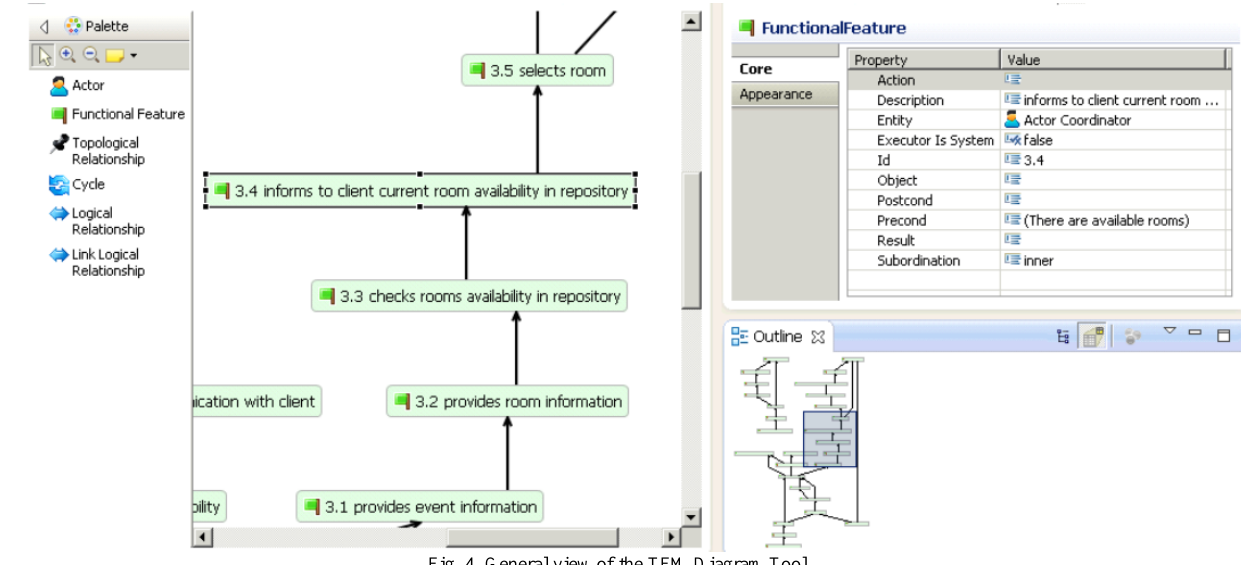
Fig. 4. General view of the TFM Diagram